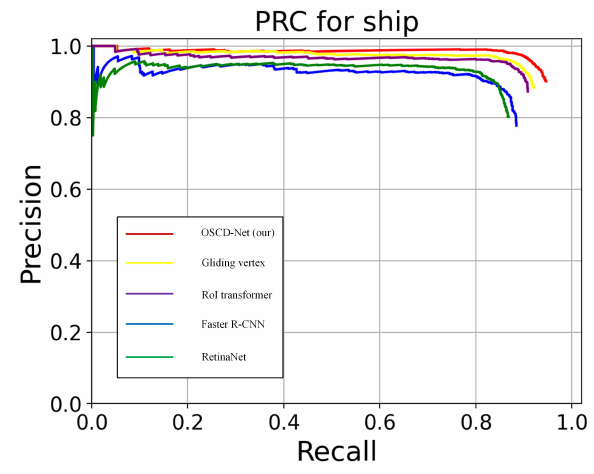
Figure 12. Precision–recall curve of different methods on the HRSC2016 dataset. 2. Experiments on DOTA-Ship: Compared with the HRSC2016 dataset, the ships in DOTA-Ship are smaller and more dense, which makes the detection task more challenging.